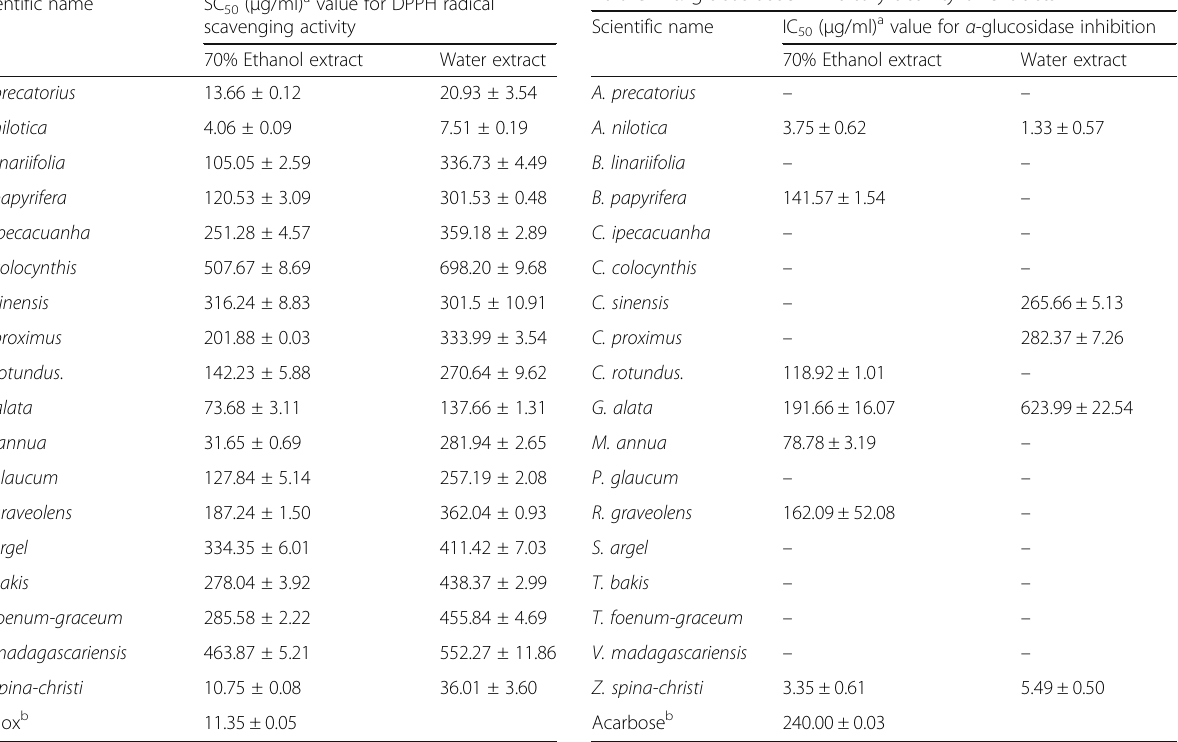
Table 4 α -glucosidase inhibitory activity of